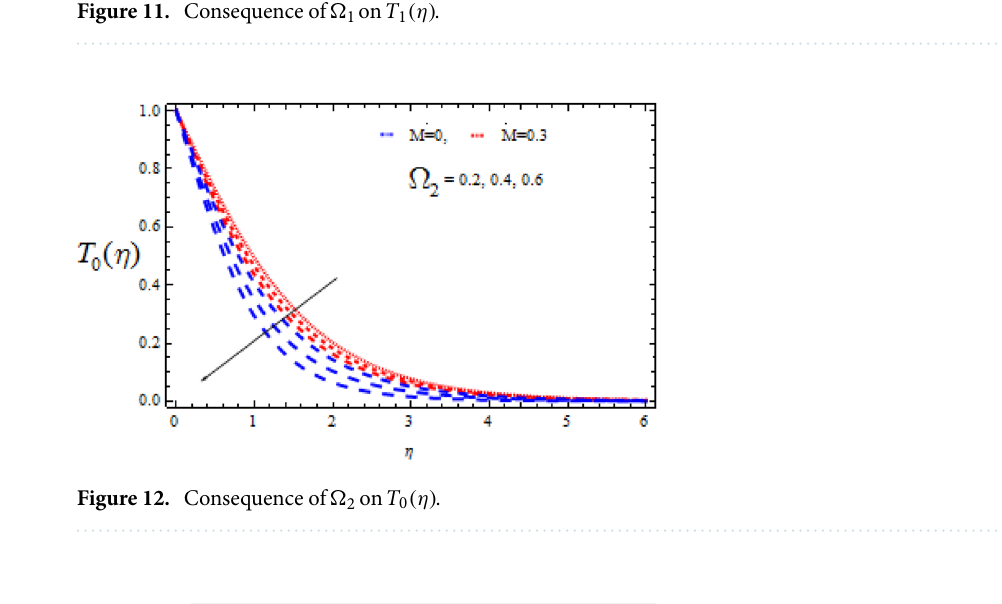
Figure 11. Consequence of (cid:31) 1 on T 1 (η) .